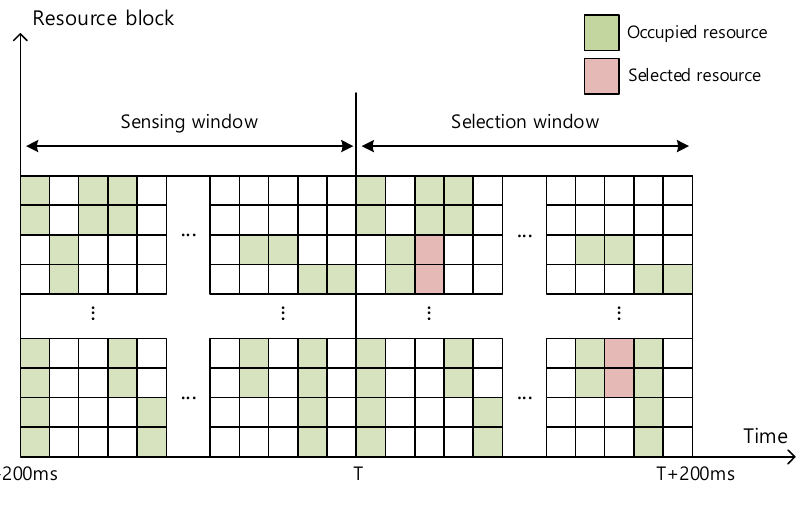
Figure 1. Sensing window and selection window.